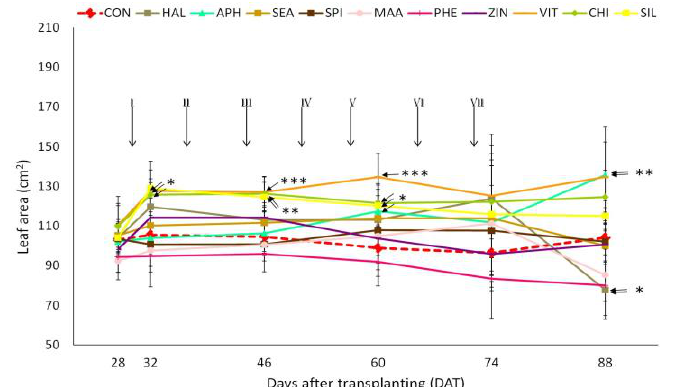
Figure 3. Leaf area dynamics during the period from 28 to 88 days after transplanting (DAT) (end of growth and production) in strawberry plants treated with different biostimulant products and water (control). Arrows indicate when the 7 biostimulant applications were performed. Vertical bars indicate mean ± SD, n = 4. The asterisk indicates significant differences according to Dunnett’s test. *** P < 0.001; ** P < 0.01; * P < 0.05; no asterisk indicates absence of any significant differences.